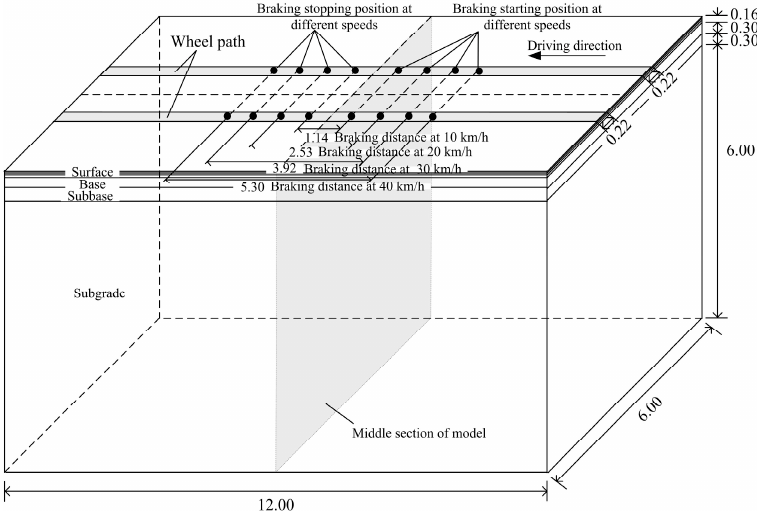
Figure 3. Schematic diagram of pavement structure with BRT vehicle braking (unit: m).